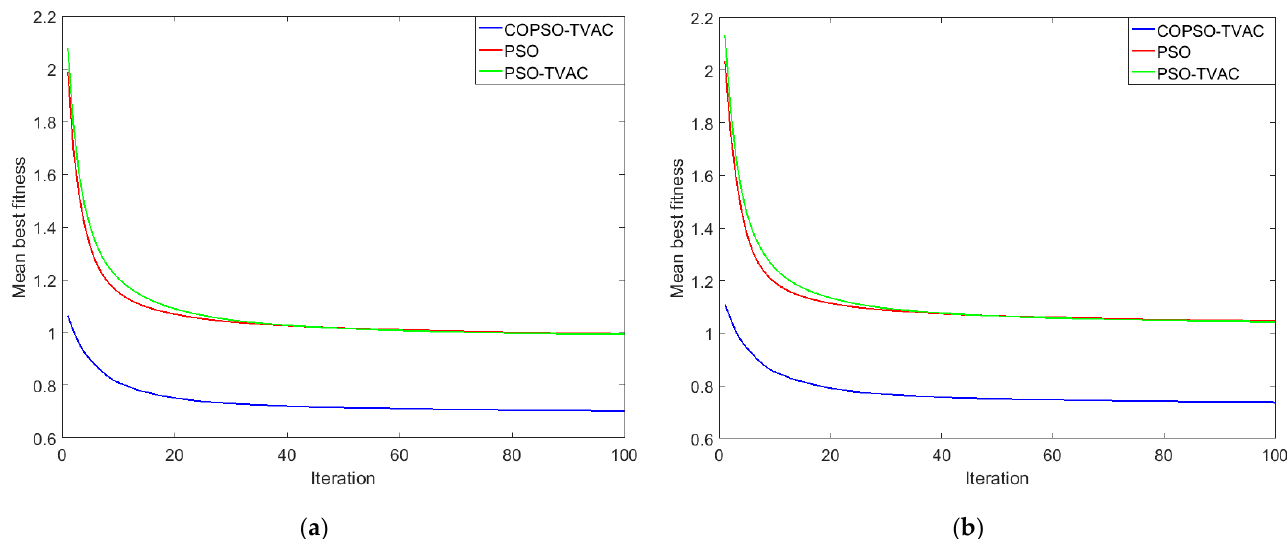
Figure 10. The convergence properties of the proposed metaheuristic algorithms in the scenario with 4 NLOS BSs: ( a ) the suburban environment; ( b ) the urban environment.